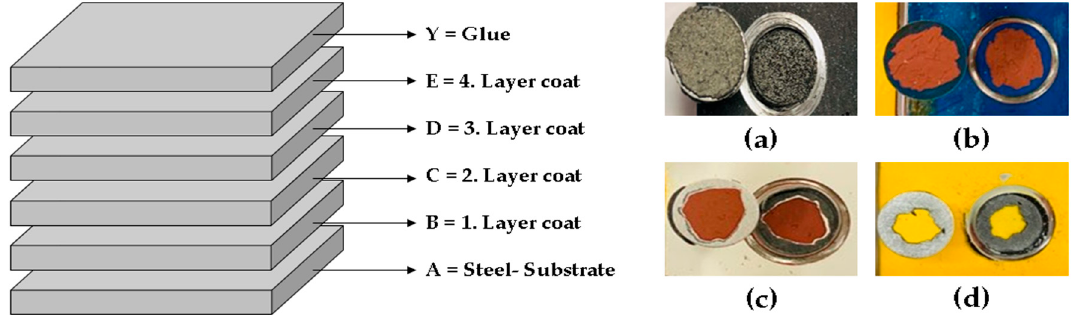
Figure 3. Coating layer fracture shape of each coating system: ( a ) Zn–Al metal spraying (MS), ( b ) Zn–Al metal spraying + epoxy coat (MC), ( c ) epoxy coat (TP), ( d ) epoxy coat + polyurethane coat (EP).